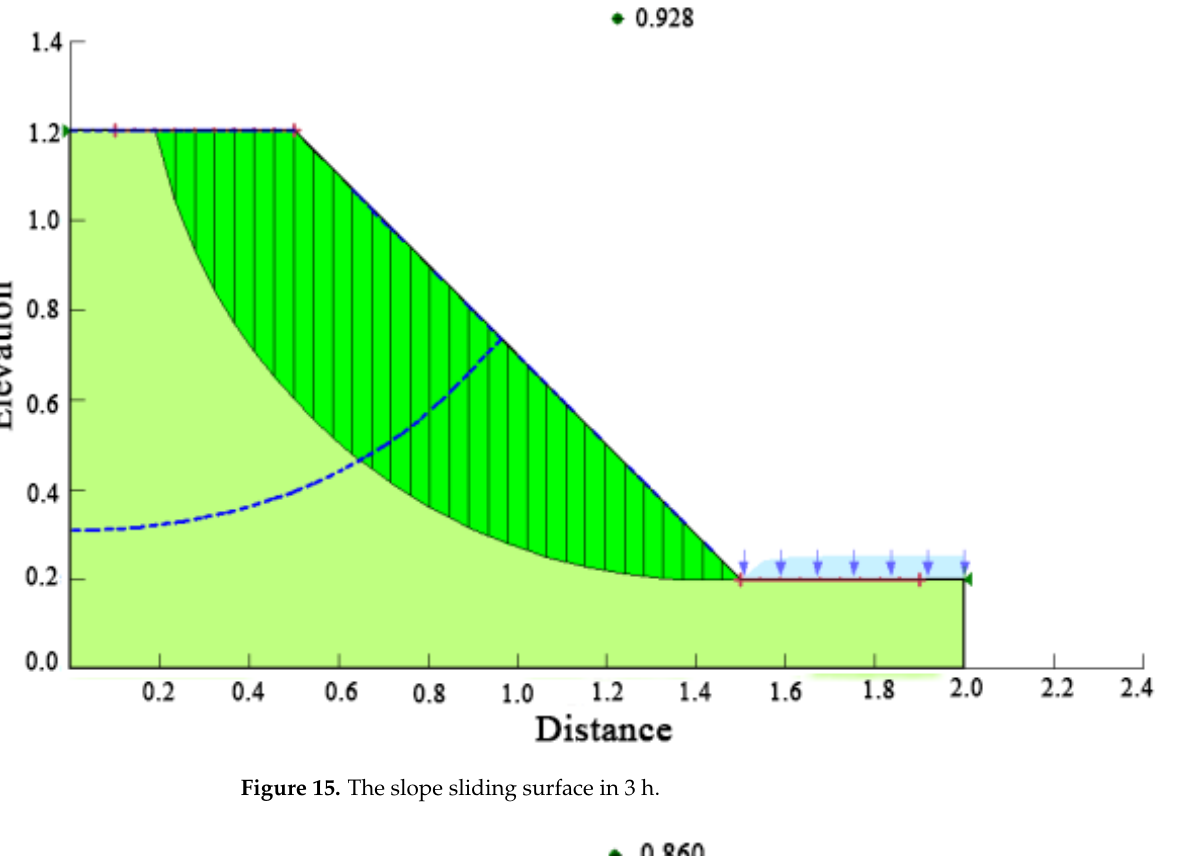
Figure 14. The slope sliding surface in 2 h.